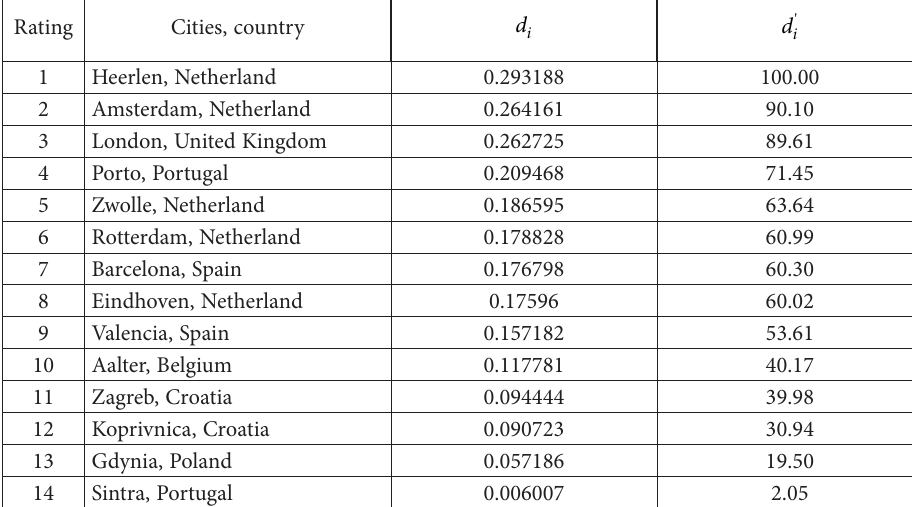
Table 4. The level of socio–economic